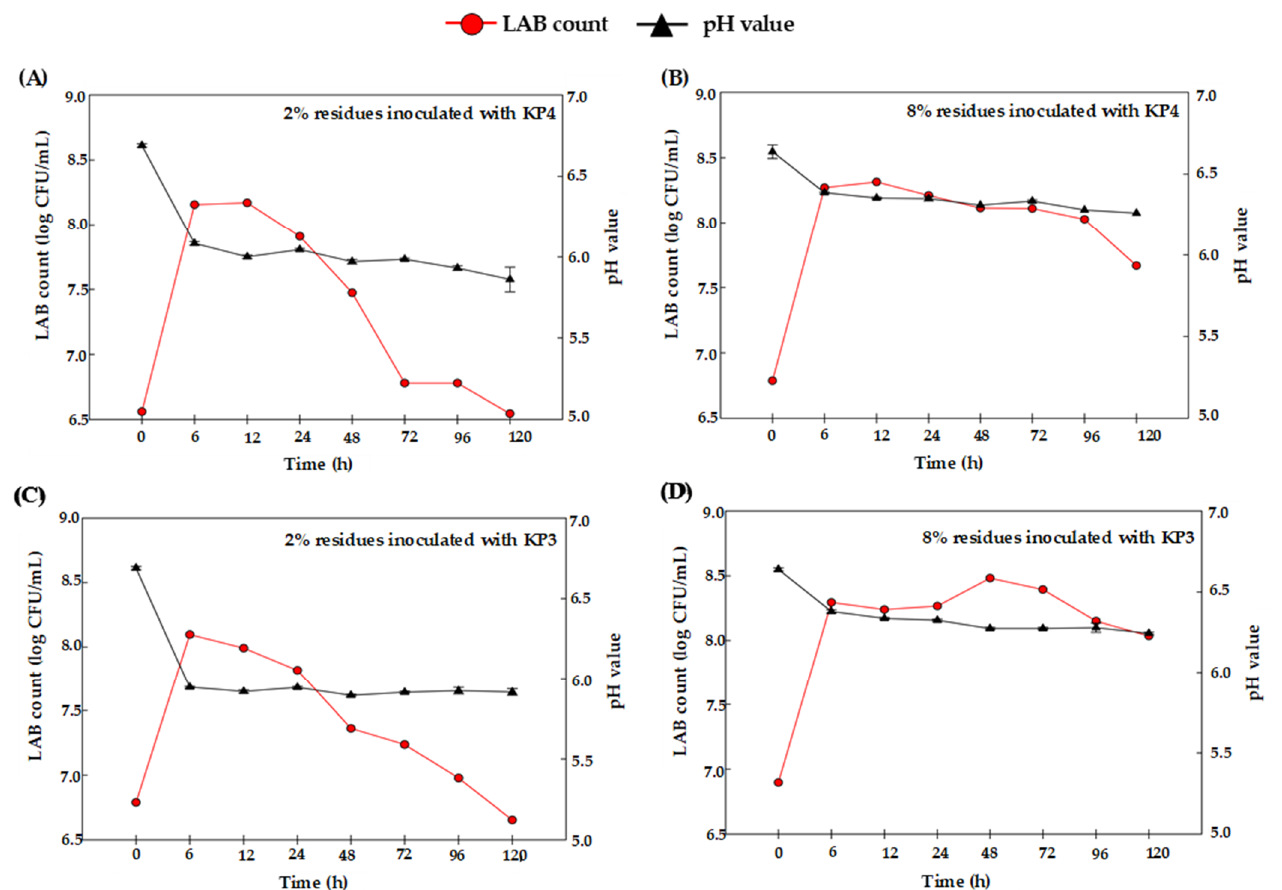
Figure 2. The LAB count and pH value of ( A , C ) 2% and ( B , D ) 8% Porphyra residues fermented with either KP4 or KP3 at 37 °C for 0 to 120 h, respectively.